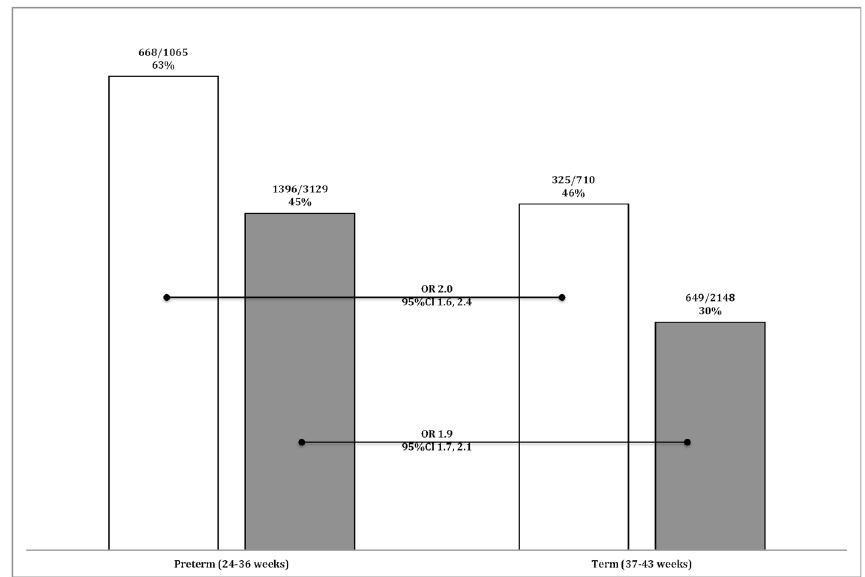
Fig 2. Prevalence of ever wheezing for the whole study population. Bars denote the percentage of children having ever wheezed who have a family history of atopy (white bars) or not (black bars) and for both gestational groups, preterm or term.